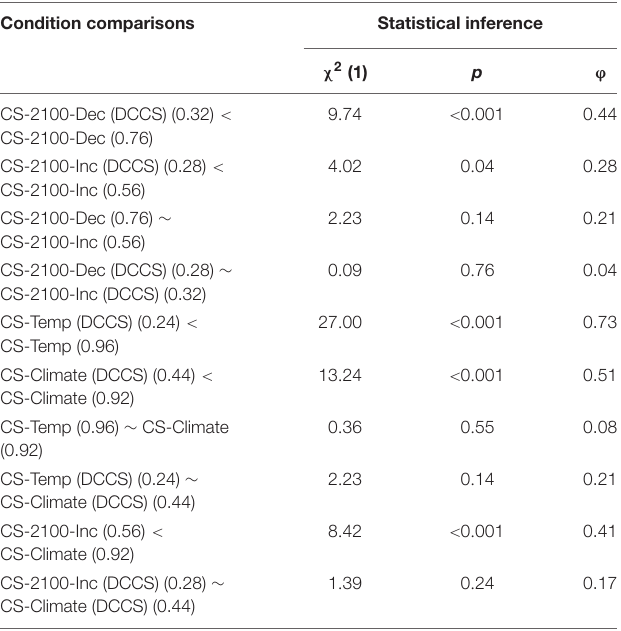
TABLE 1 | Comparison of different conditions involving correlation heuristic reliance among